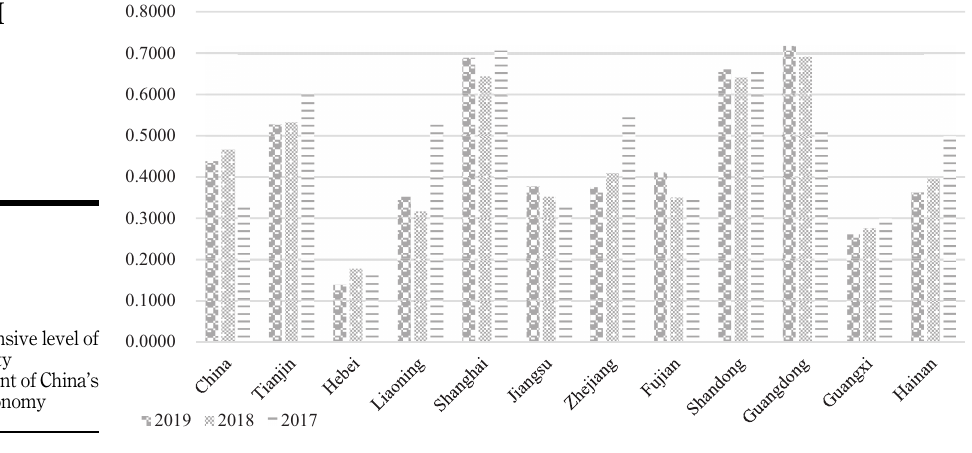
Figure 1. Comprehensive level